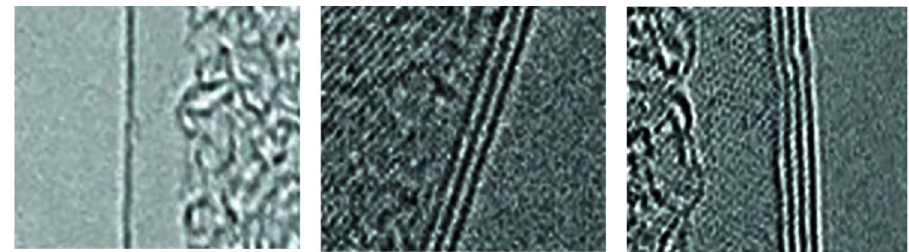
Figure 5. Graphene image of the scanning electron microscopy of graphene synthesis on the substrate.